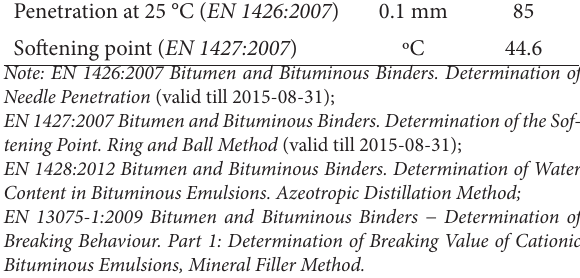
Table 1: large Expansion Ratio and long bitumen foam Half-